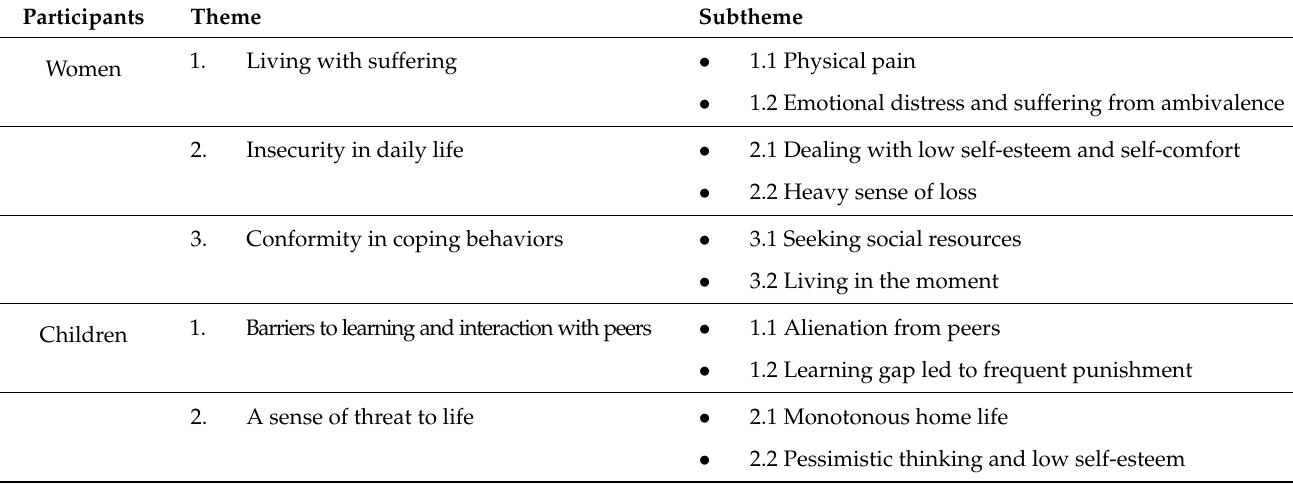
Table 1. Summary of themes and subthemes emerging from the